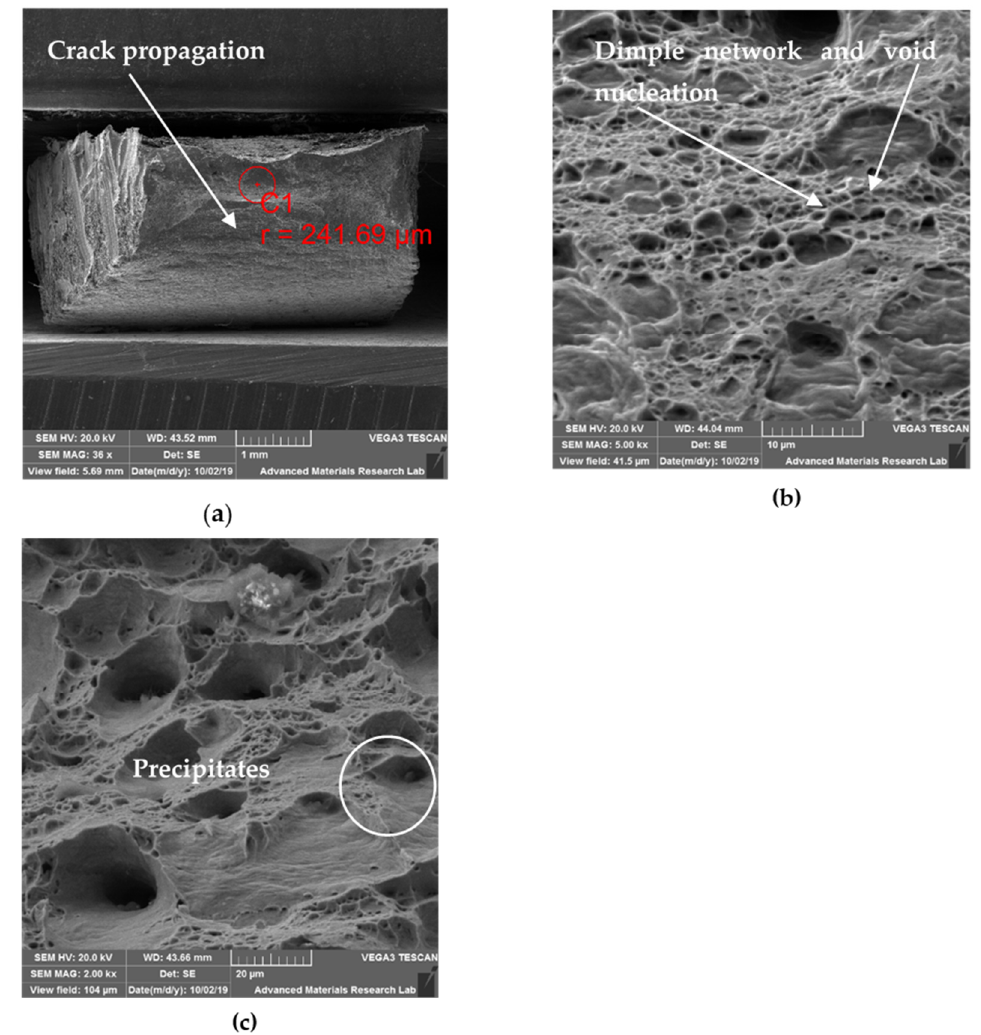
Figure 15. SEM fractography images of CT specimen: ( a ) 35×; ( b ) 2000×; ( c ) 5000×.